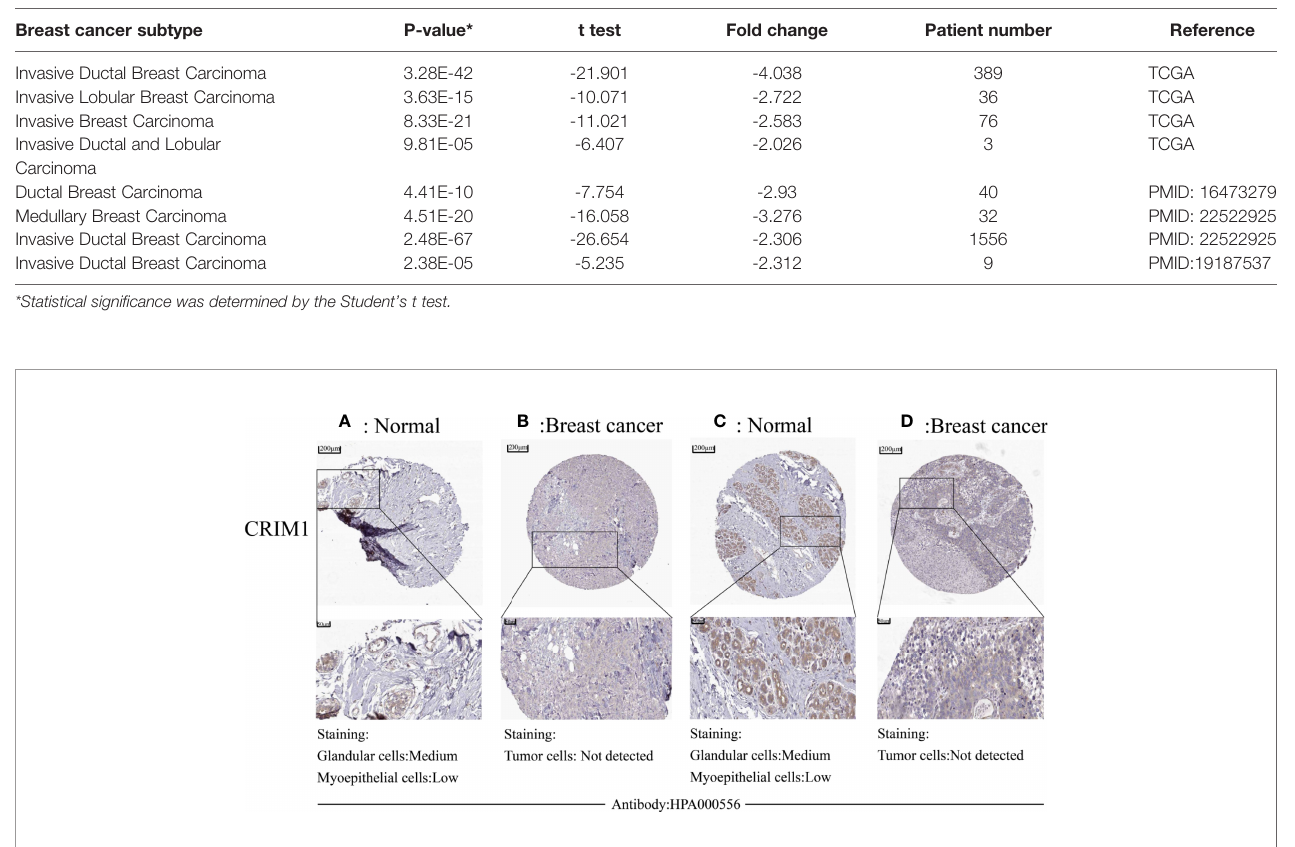
FIGURE 2 | Downregulation of protein levels in breast cancer tissues was observed in human protein atlas. CRIM1 protein levels were medium in glandular cells and low in myoepithelial cells (A, C) , and were negative in tumor cells (B, D) .